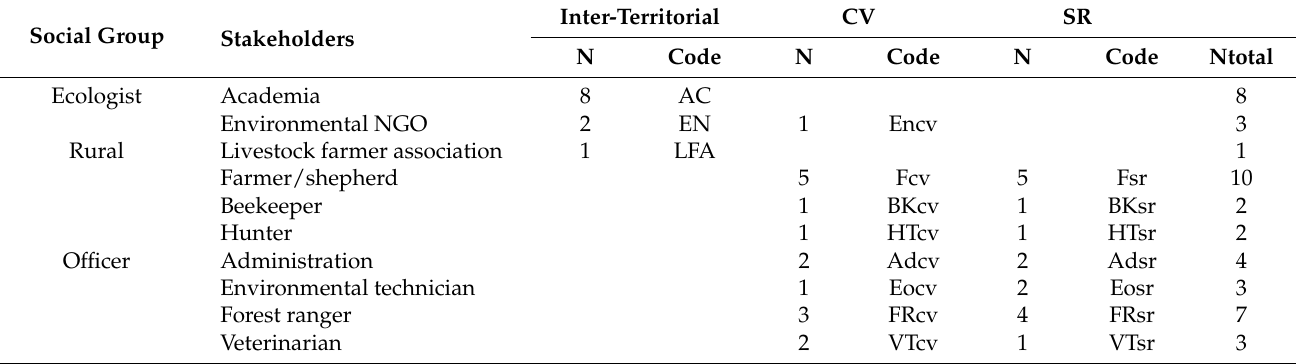
Table 1. Number (N) and type of stakeholders interviewed arranged in three social groups and by study area. Code: identification of stakeholders for recognizing the quotes in the text. All officers work for the local/regional government on environmental projects. CV: Colmenar Viejo and Tres Cantos; SR: Sierra del Rinc ó